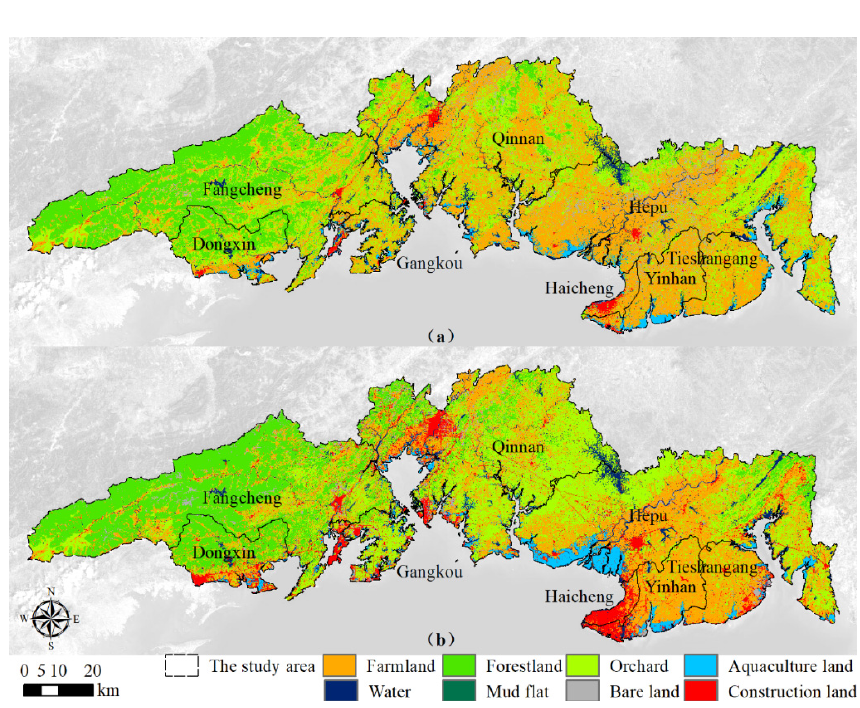
Figure 2. Land use maps of the study area in 1999 ( a ) and 2014 ( b